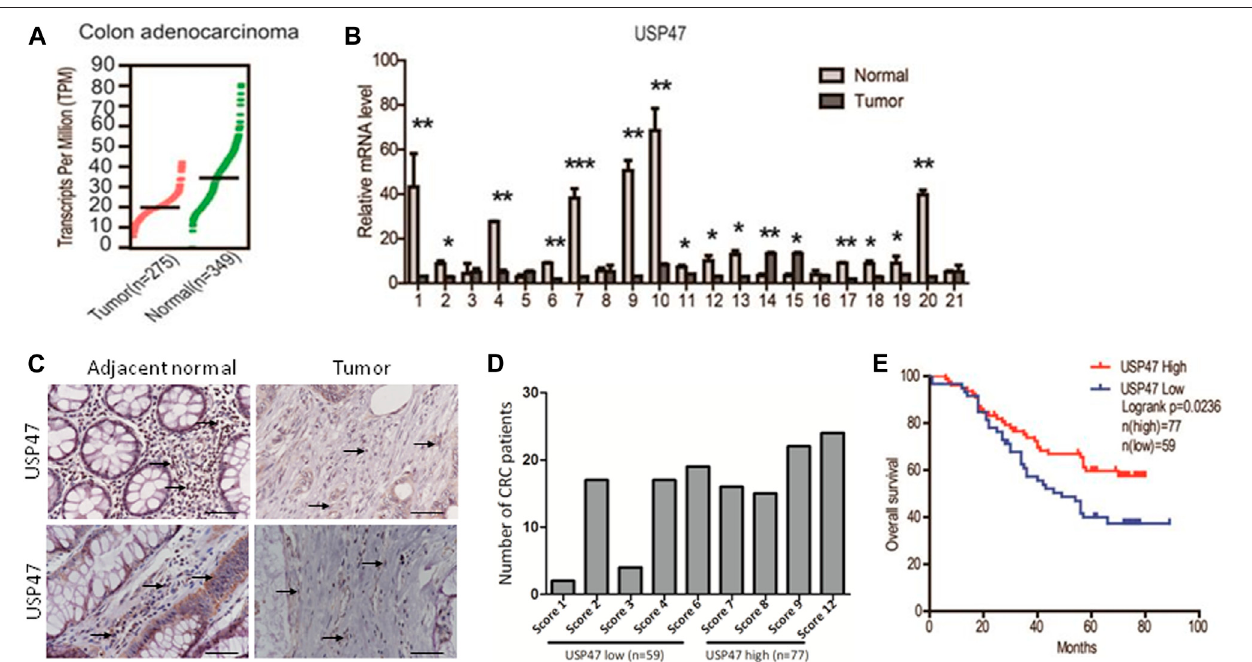
FIGURE 1 | Decreased expression of USP47 is associated with shorter disease-free survival time of CRC patients. (A) USP47 expression levels in colon adenocarcinomaandadjacentnormaltissuesretrievedfromGEPIAdatabase.Log2(TPM+1)transformeddatawasusedintheplot. (B) ThemRNAlevelsofUSP47in21 pairs of CRC and adjacent normal tissues were quantitated by RT-qPCR. The relative levels of the target genes were normalized to that of β -actin. The data were independently repeated three times and presented as the means ± SD, * p < 0.05, ** p < 0.01. (C) Anti-USP47 immunohistochemistry of CRC and adjacent normal tissues. (D, E) Analyses of anti-USP47 immunostaining scores (D) and the disease-free survival of CRC patients (E) . CRC, colorectal cancer.